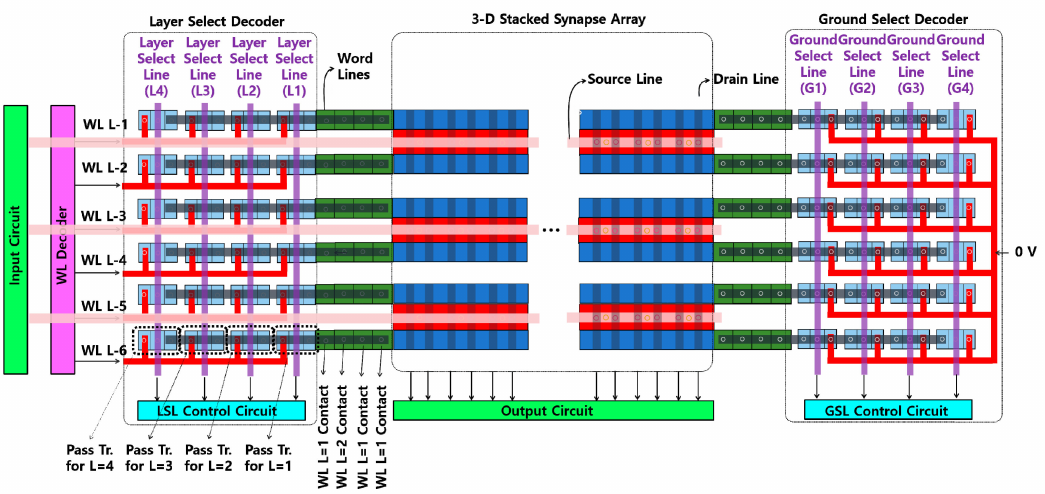
Figure 4. Top view image of the revised synapse array